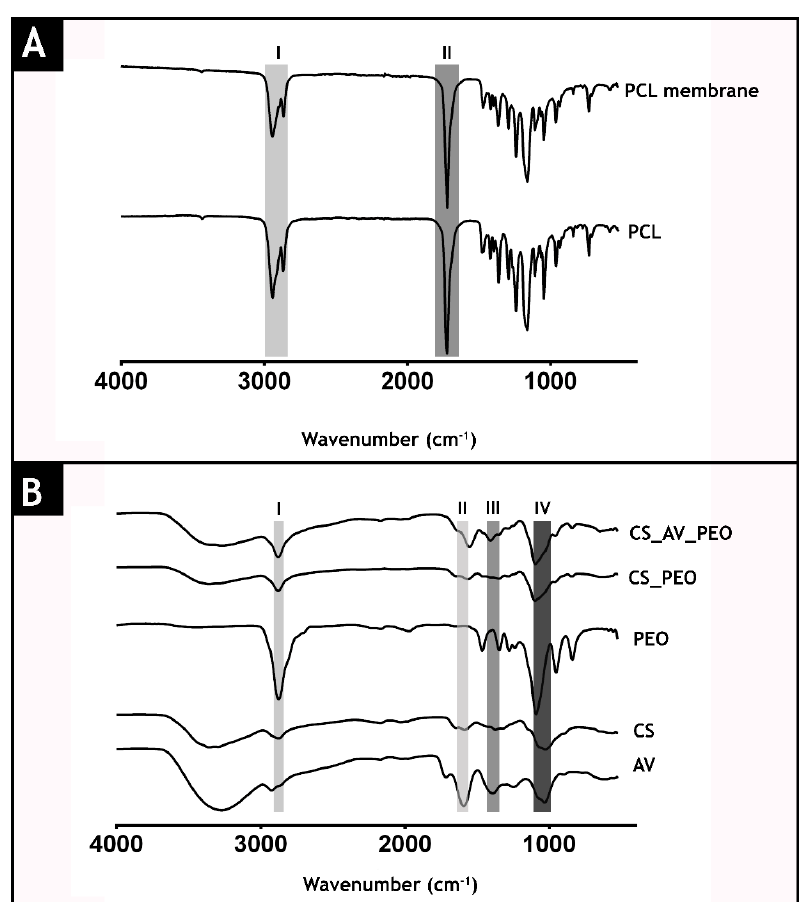
Figure 3. Attenuated total reflectance-Fourier transform infrared spectroscopic analysis (ATR-FTIR) of the produced membranes and of their raw materials: top layer ( A ) and bottom layers ( B ).